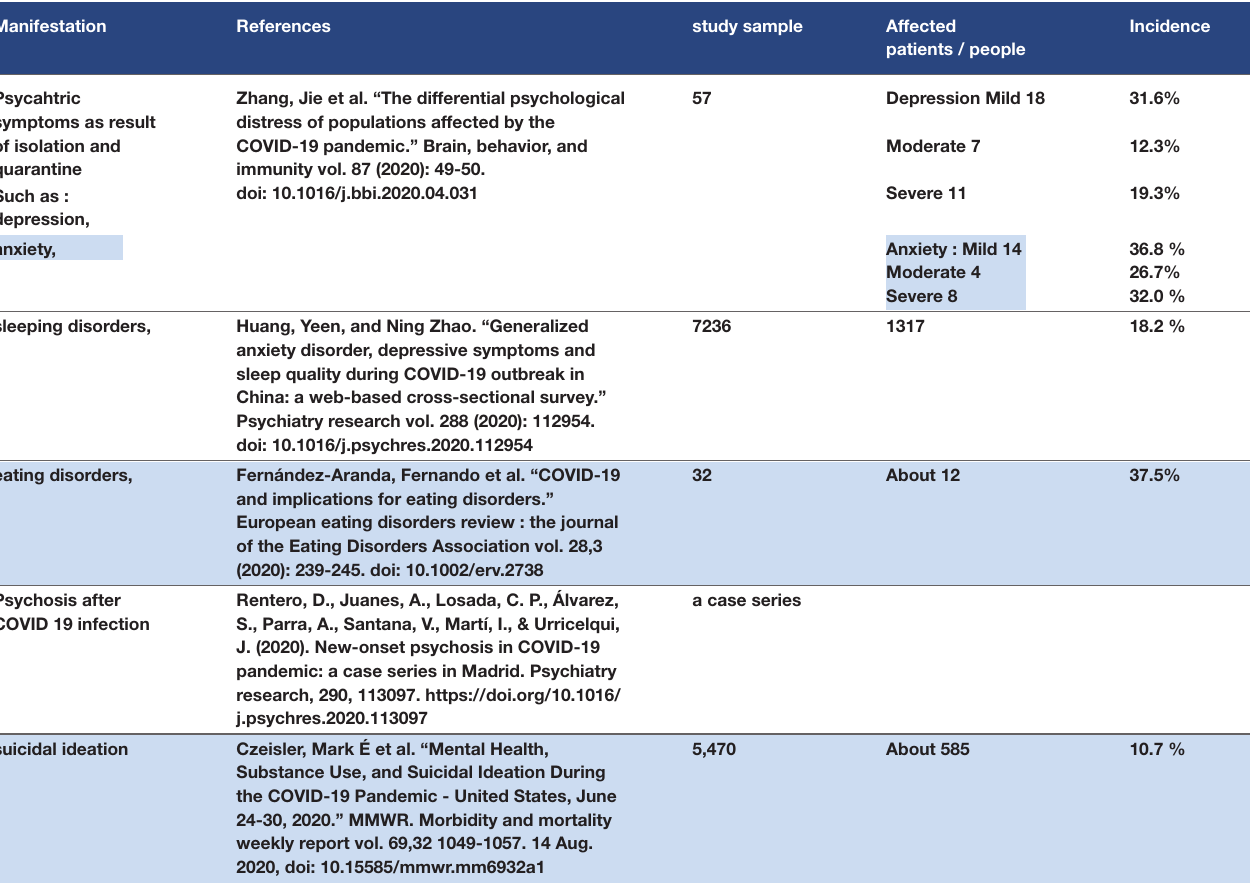
TABLE 6 | Psycahtric manifestations of COVID 19.